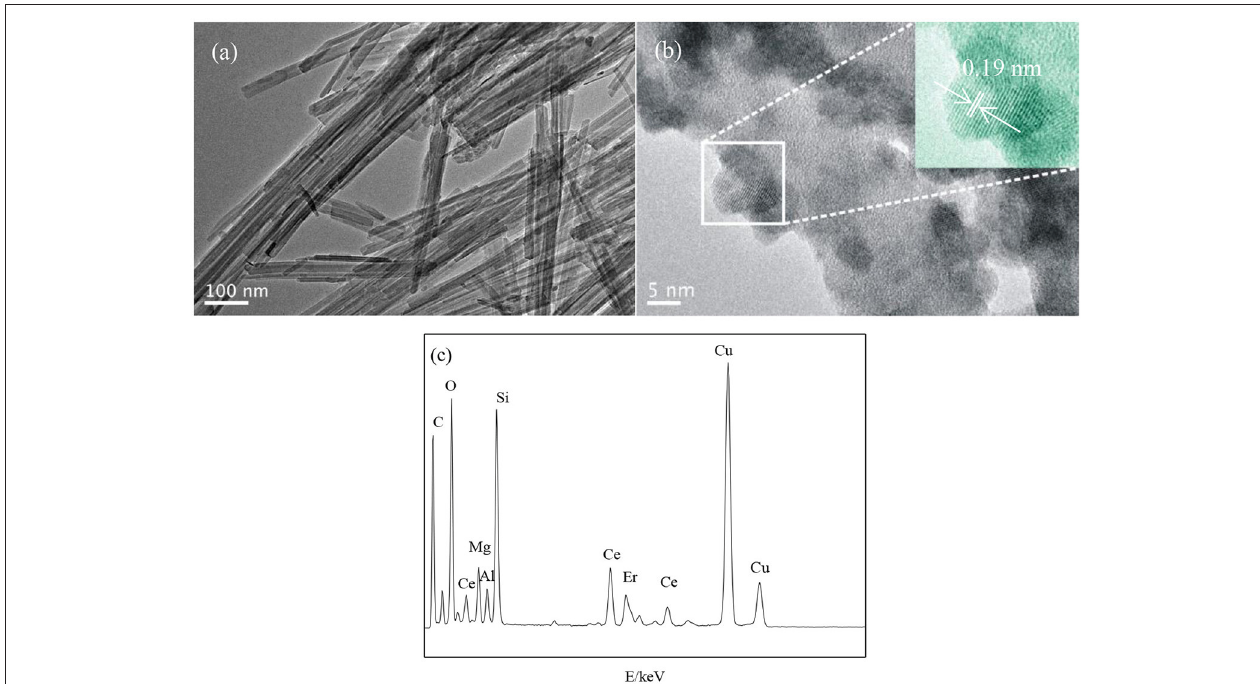
FIGURE 4 | TEM images of ATP (a) , Er 3 + :CeO 2 /ATP (b) , and EDS of Er 3 + :CeO 2 /ATP (c) .